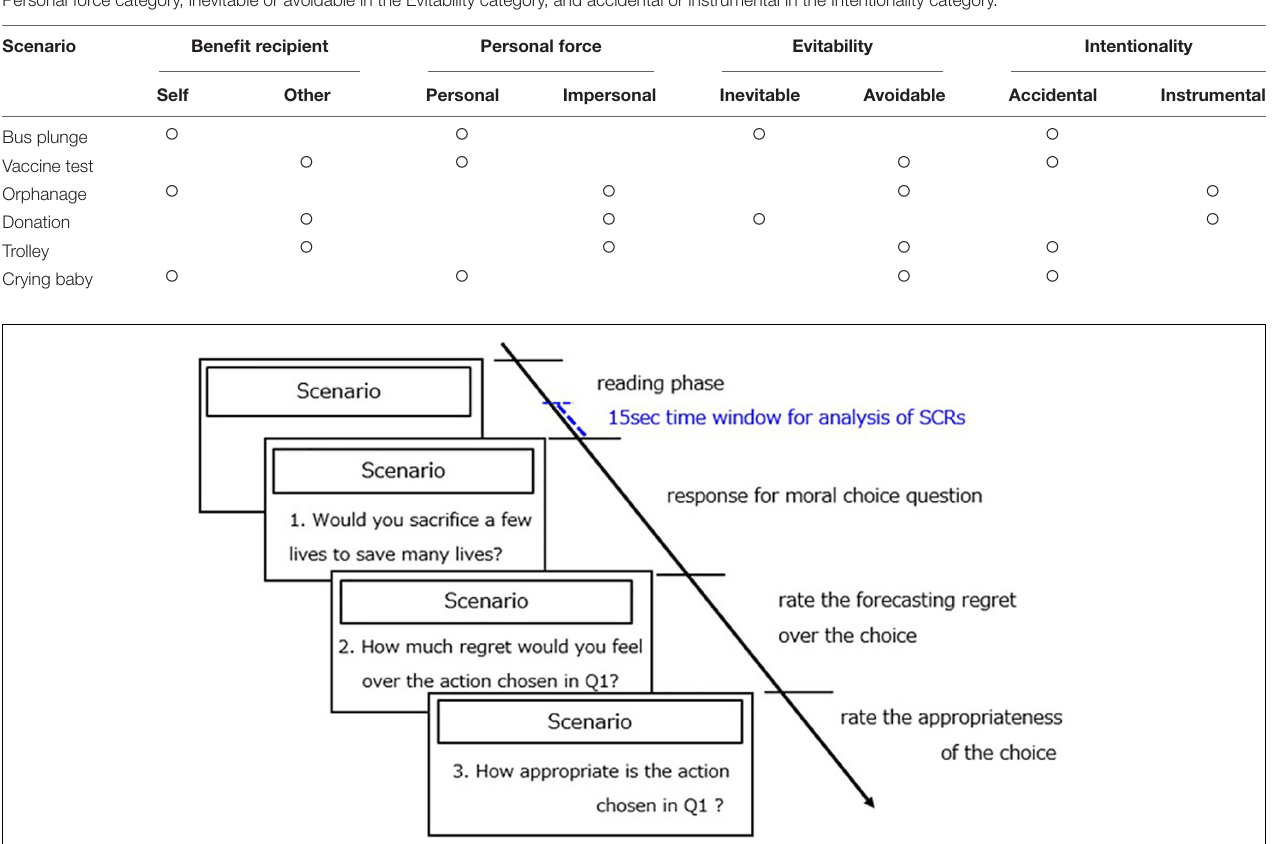
FIGURE 1 | The flow of a moral-dilemma trial. Each trial required the participants to answer three questions about one moral dilemma scenario: The first question asked whether the participants would sacrifice a few lives to save many lives (affirmative answer, utilitarian; negative answer, deontic). The second question asked the participants to rate the extent of the regret they would experience over their answer to the first question. The third question asked the participants to rate the appropriateness of their choice in response to the first question. The participant’s SCRs and reaction time were recorded during the